Question: Provide a one-line summary of what is displayed.
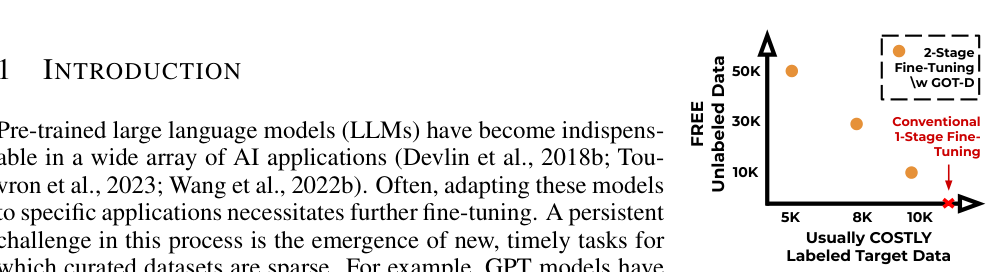
Answer: Benefits of two- stage fine-tuning. All settings presented achieve the same task performance. Evaluation is performed on the CoLA dataset (Wang et al., 2018).